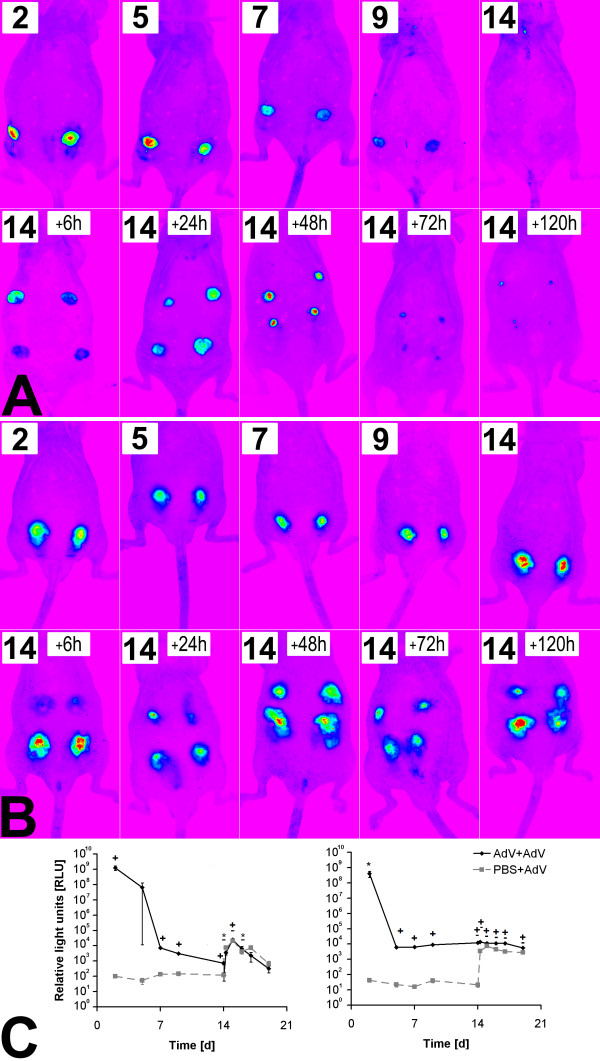
Investigation of adenovirus induced transgene expression in vivo. Qualitative GFP fluorescence (relative light units; RLU) detection of immunocompetent (SKH-1h/r (A)) and athymic (Foxn-1nu (B)), hairless mice at timepoints 2 - 19 days after intradermal injection of 1010 IU Ad-GFP at day 0 and reinjection of the same areas and transduction of a third area on day 14 (* = p < 0.05, + = p < 0.005 (AdV+AdV); - = p < 0.005 (PBS+AdV)). (C) Quantitative (RLU) GFP-fluorescence detection of an athymic (Foxn-1nu) and immunocompetent mice (SKH-1h/r) at timepoints 2 - 19 days after intradermal injection of 1010 IU Ad-GFP at day 0 and reinjection of the same areas and transduction of two new areas on day 14.